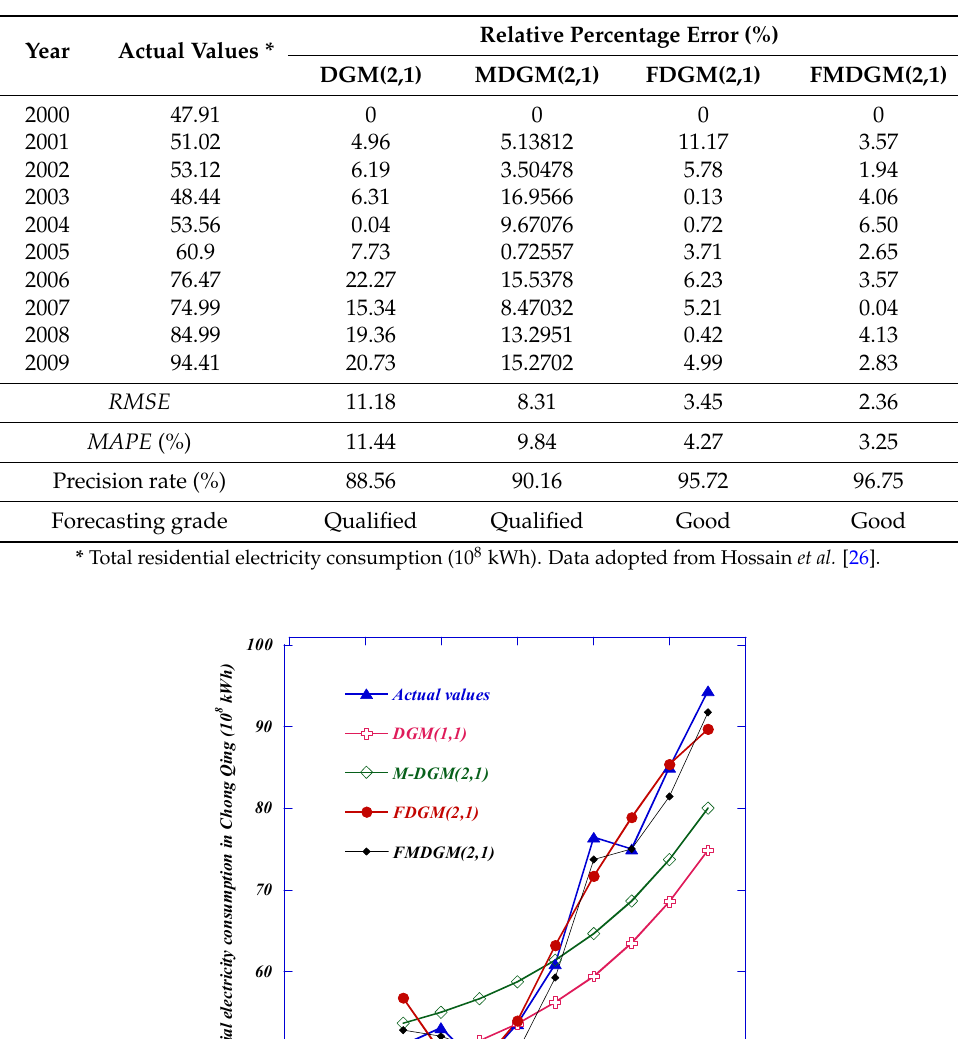
Table 4. Forecasting results for the residential electricity consumption in Chong Qing.